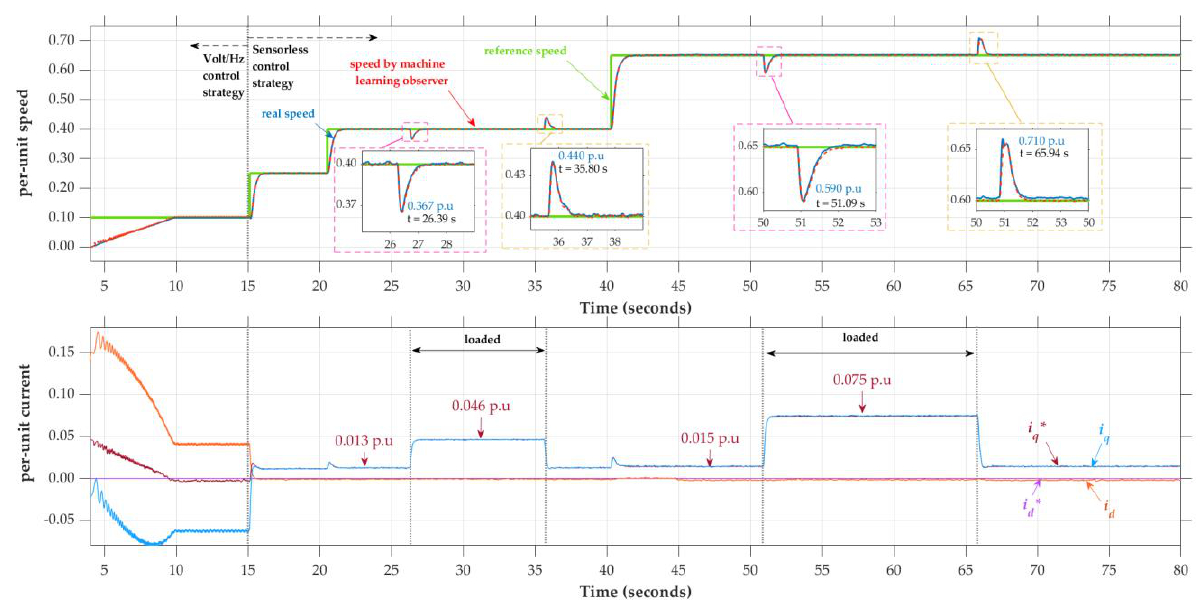
Figure 18. Experimental results for speed and current responses with external load variations at 0.40 and 0.65 p.u-speed.